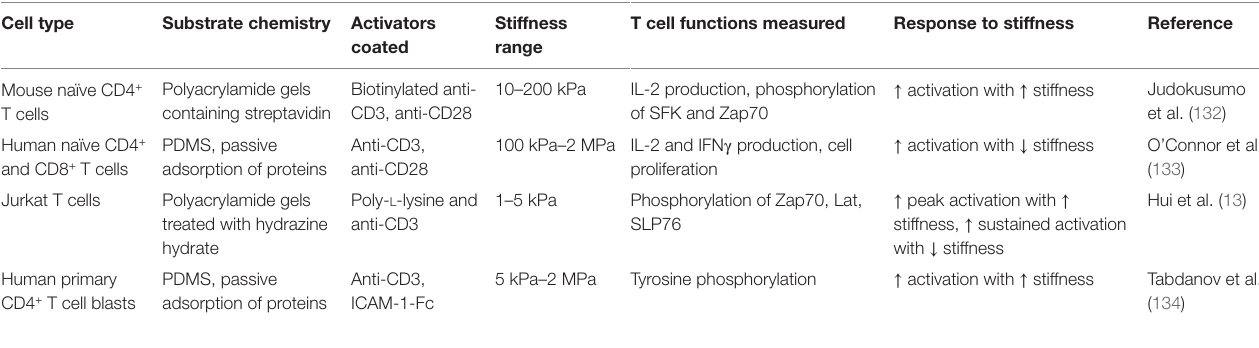
TABLe 1 | T lymphocyte response to substrate